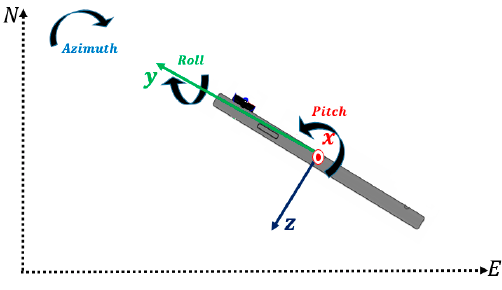
Figure 4. iPhone 6 Rotation Angles Definition.